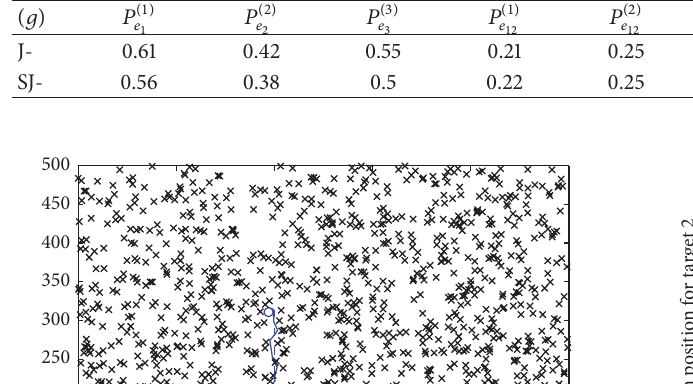
Table 3: The 𝑃 (𝑗) 𝑒 obtained by “J-” and “SJ-”: three-target situation. 𝑟